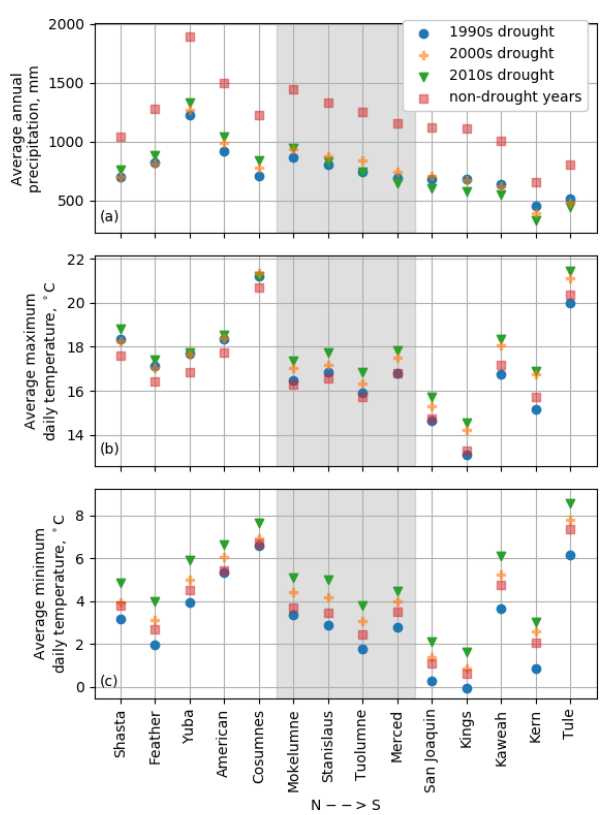
Figure 3. Climatic conditions during drought periods. The central Sierra is shaded in gray, with the northern and southern basins to the left and right, respectively. The most recent drought (2010s) was the wettest drought in the northern Sierra but the driest in the southern Sierra (a) . Maximum temperatures only increase in the central and southern Sierra (b) , but minimum temperatures increase across the whole study area (c)